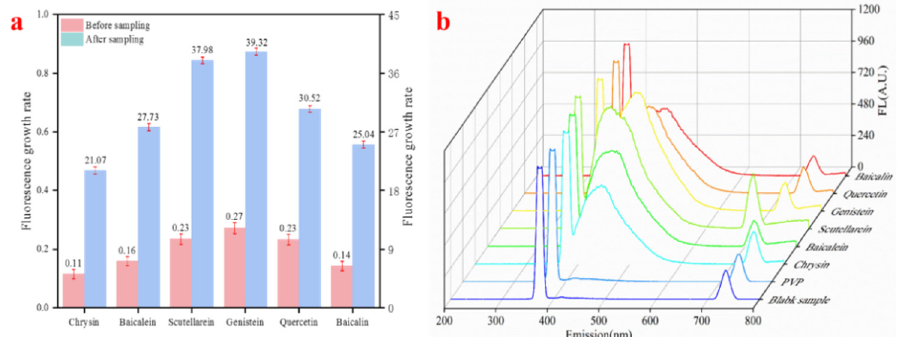
Figure 5. Fluorescence and fluorescence enhancement in the active molecular membrane trap cham- ber after simulated ROS radical reaction ( a ) Fluorescence enhancement graph, ( b ) Fluorescence spectrum graph.